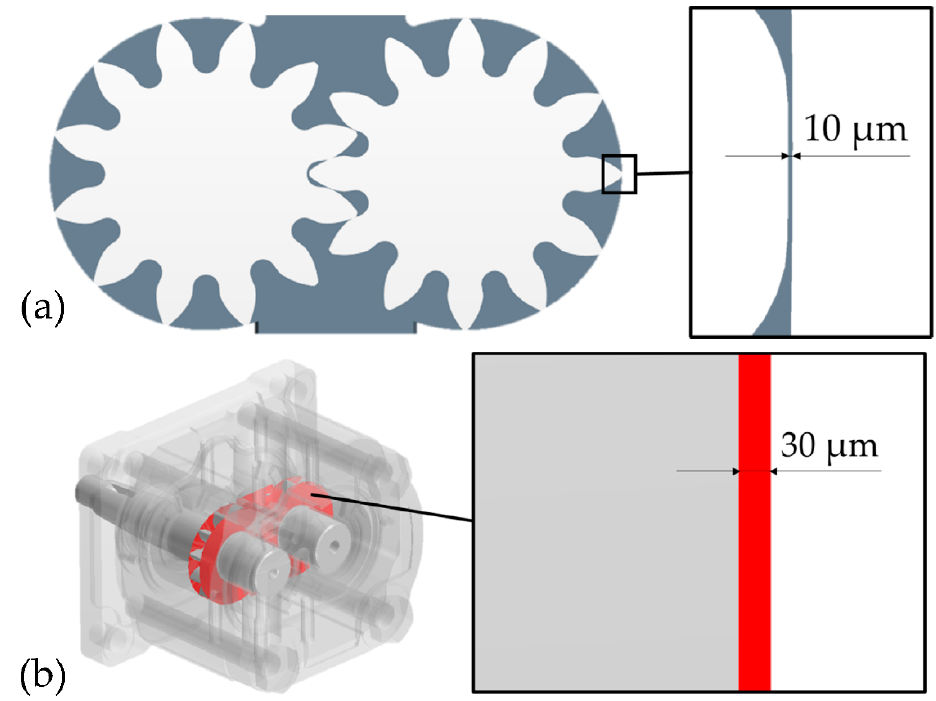
Figure 3. Internal leakages of the pump: ( a ) 10- μ m radial leakage; ( b ) 30- μ m axial leakage.